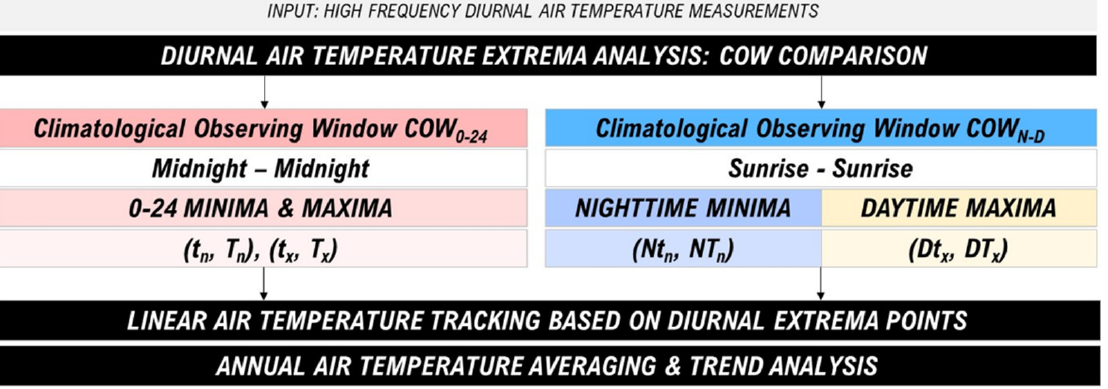
Figure 4. Approach for diurnal air temperature analysis and comparison of COW 0–24 and COW N–D methods.